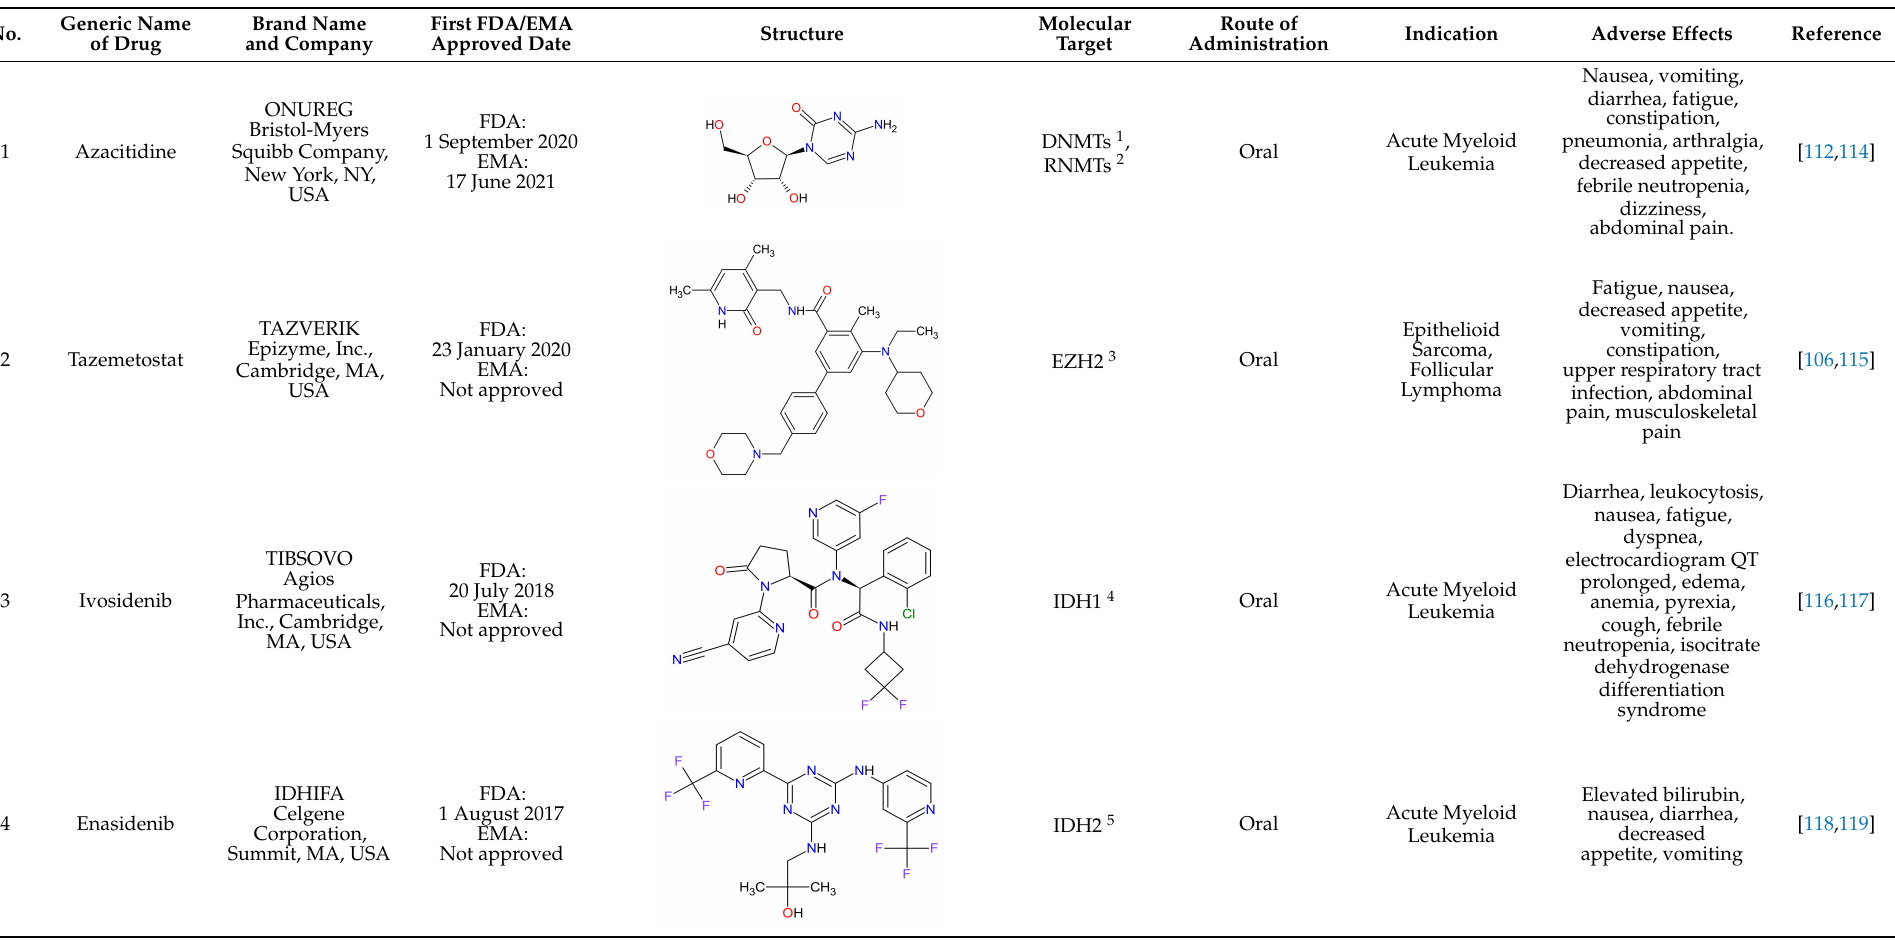
Table 4. Features of the other enzymes inhibitors approved by the Food and Drug Administration (FDA) from 2011 to 2021. The order of drugs is tabulated in order of most recent to oldest registration